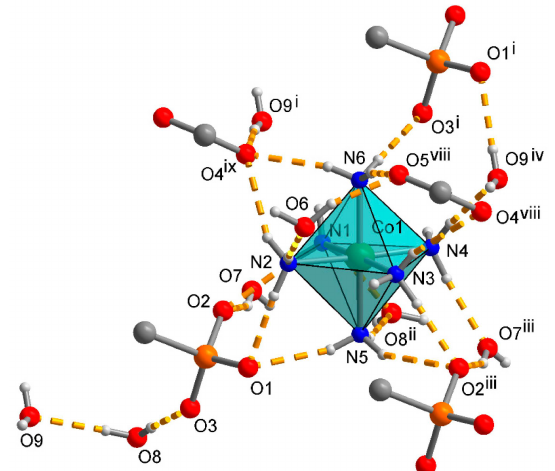
Figure 4. Most relevant H-bonding interactions (orange dashed lines) around a [Co(NH 3 ) 6 ] 3+ cation in the structure of 2 . Details of the H-bond distances and angles are listed in Table 4. Symmetry